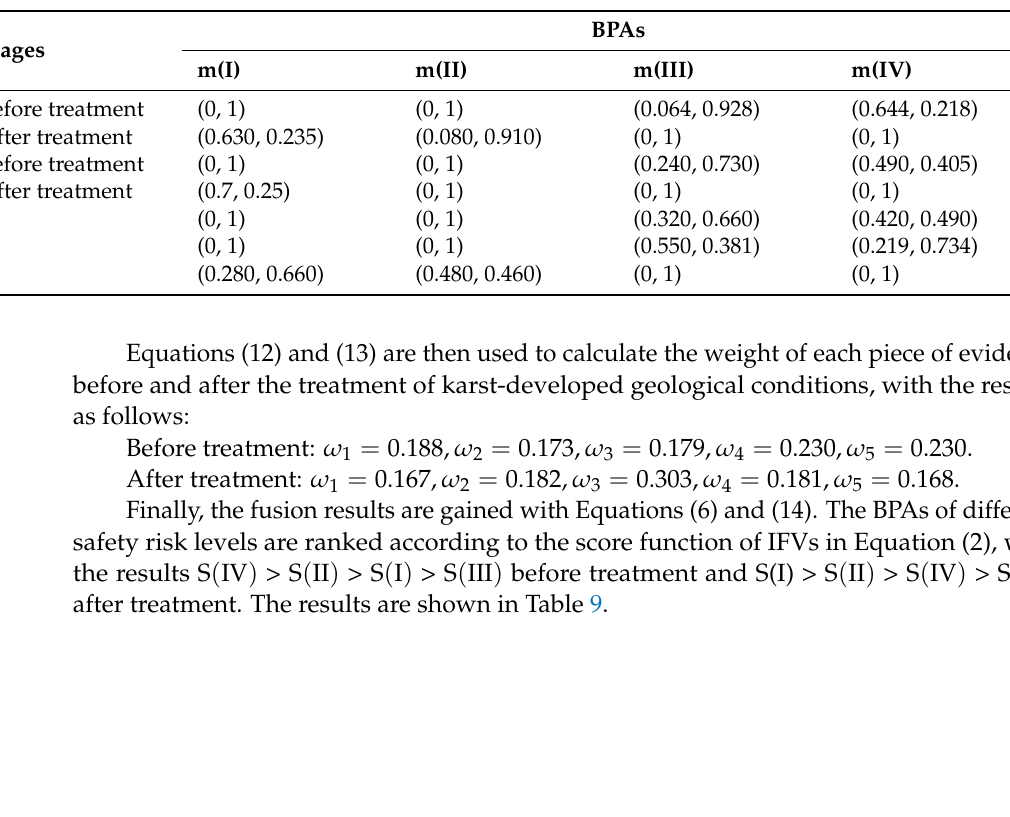
Table 8. BPAs of influential factors before construction.